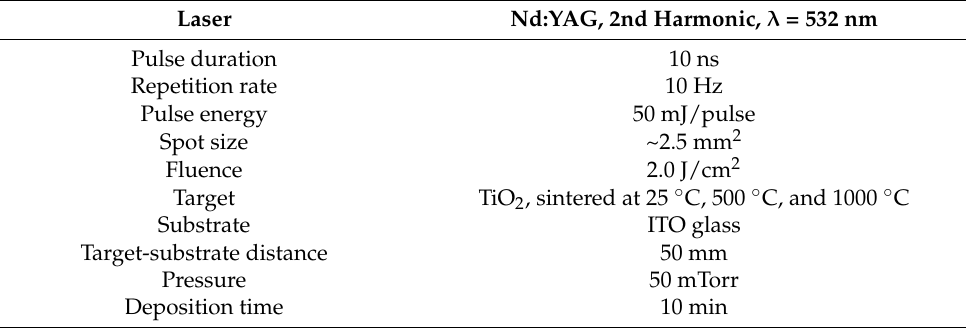
Table 1. Deposition parameters used for the nanosized TiO 2 film